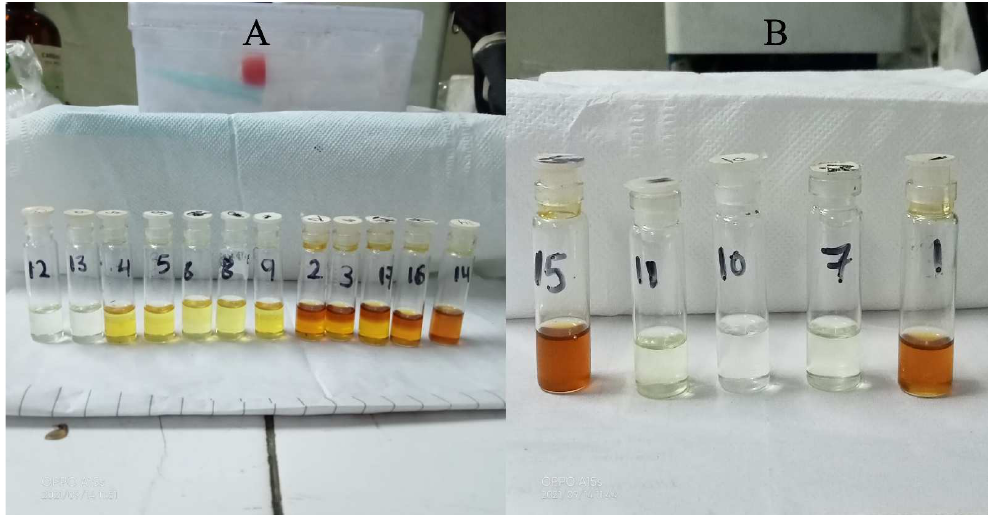
Figure 2. ( A , B ) depict the mixtures with phase separation and the clear mixtures, respectively.